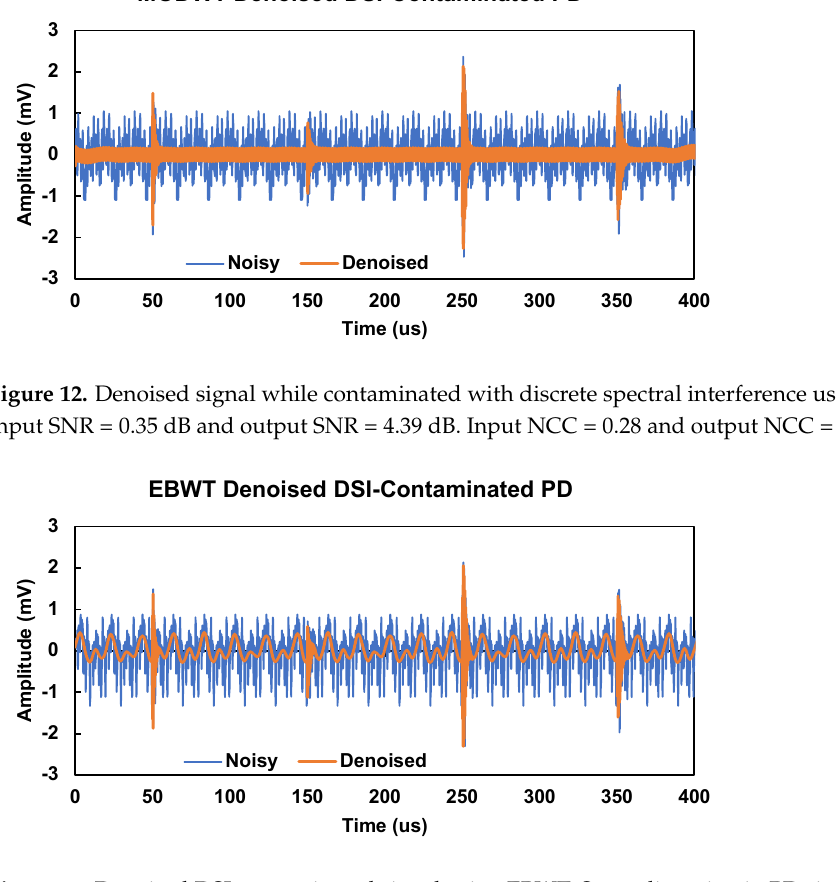
Figure 13. Denoised DSI-contaminated signal using EBWT. Some distortion in PD signal is noticed. Input SNR = 0.34 dB, output SNR = 1.61 dB, input NCC = 0.28 and output NCC =